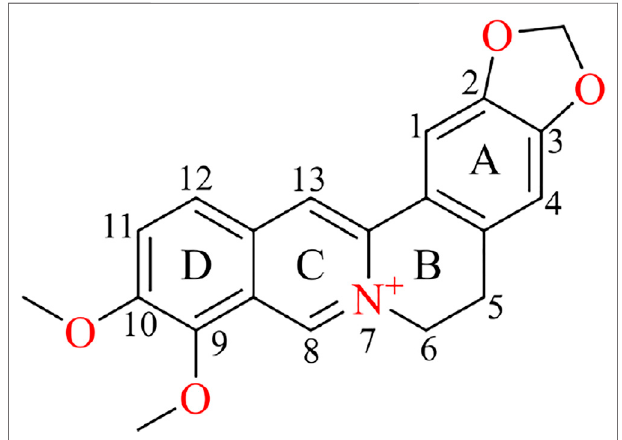
FIGURE 1 | Schematic representation of the chemical structure of berberine.